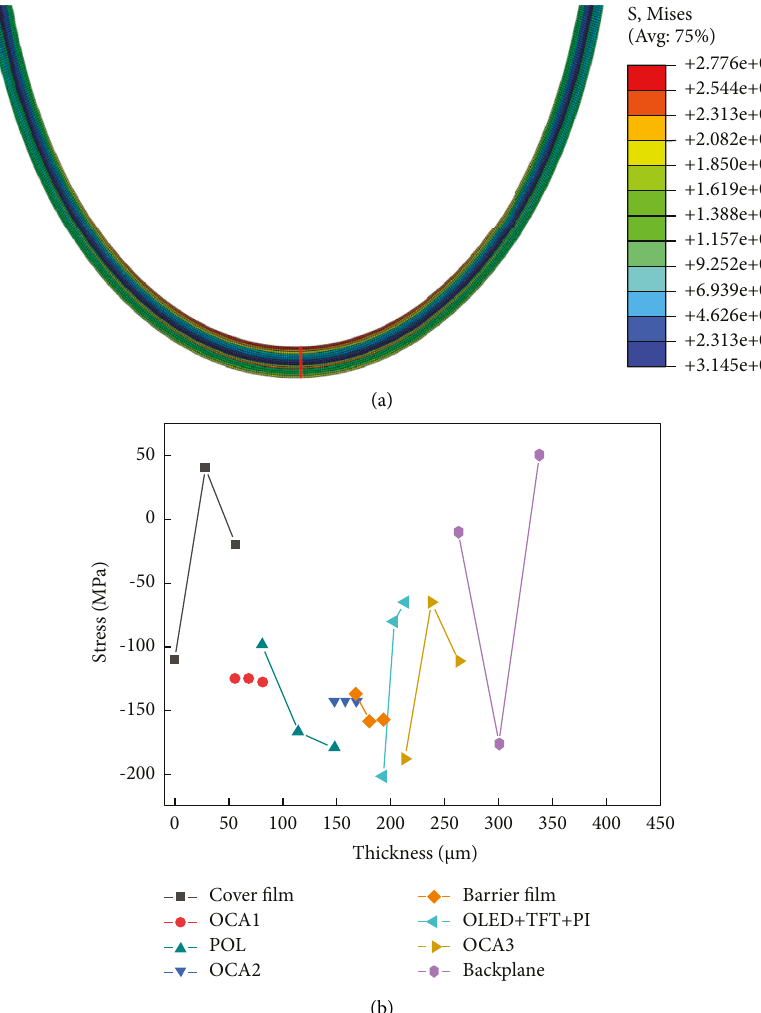
Figure 7: (a) The left is a cloud map of normal stress changes and a thickness map of stress changes. (b) The left half of each number is compression stress, and the right half is the stretch